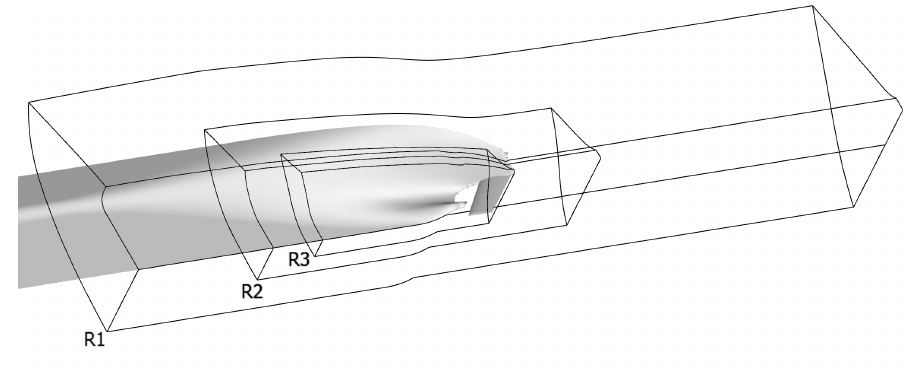
Figure 5. Systematic refinement variation in three steps for R1, R2, and R3